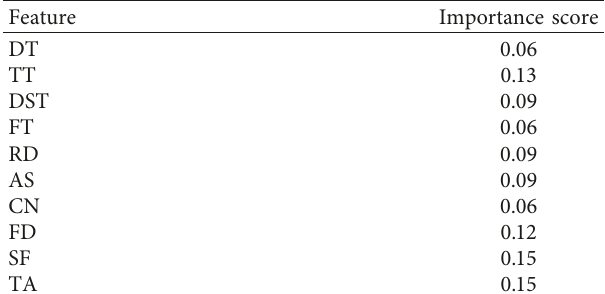
Table 6: Feature importance score of the 10 selected attributes. Feature